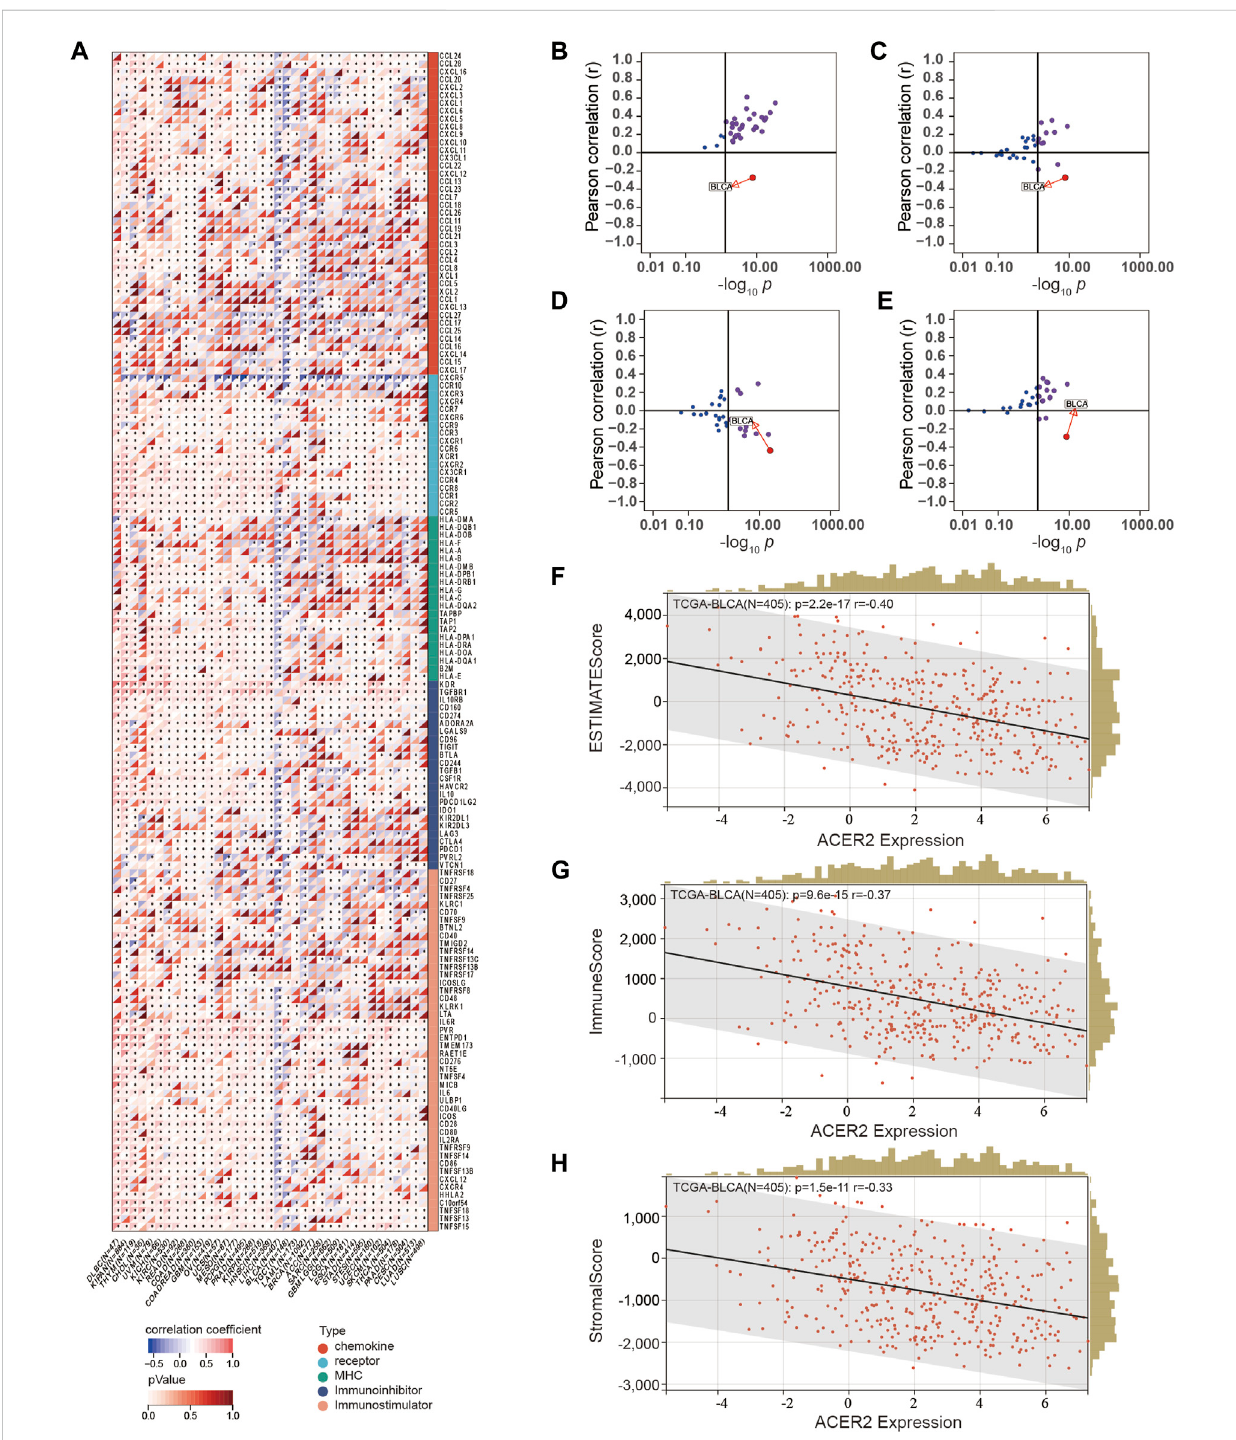
FIGURE 1 Correlations between ACER2 with immunological characteristics in pan-cancers. (A) Correlation between ACER2 and 122 immunomodulators (chemokines,receptors,MHC,andimmunostimulators). (B – E) CorrelationbetweenACER2andfourimmunecheckpoints,namely,PD-L1,CTLA-4,PD-1, and LAG-3. (F – H) Correlation between ACER2 expression and the ESTIMATE score, Immune score and Stromal score in